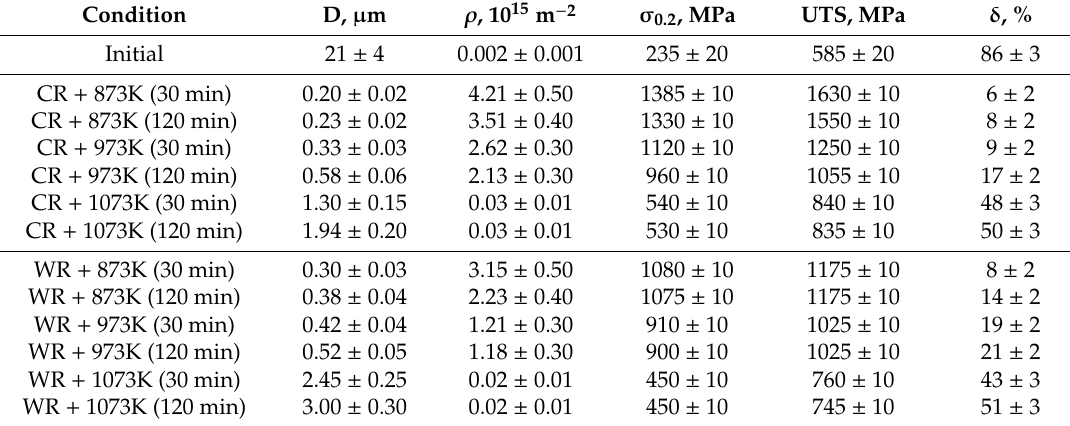
Table 1. The grain size (D), the dislocation density ( ρ ), the yield strength ( σ 0.2 ), the ultimate tensile strength (UTS) and the total elongation ( δ ) of a 316L-type stainless steel subjected to cold rolling (CR) or warm rolling (WR) and subsequent annealing at indicated